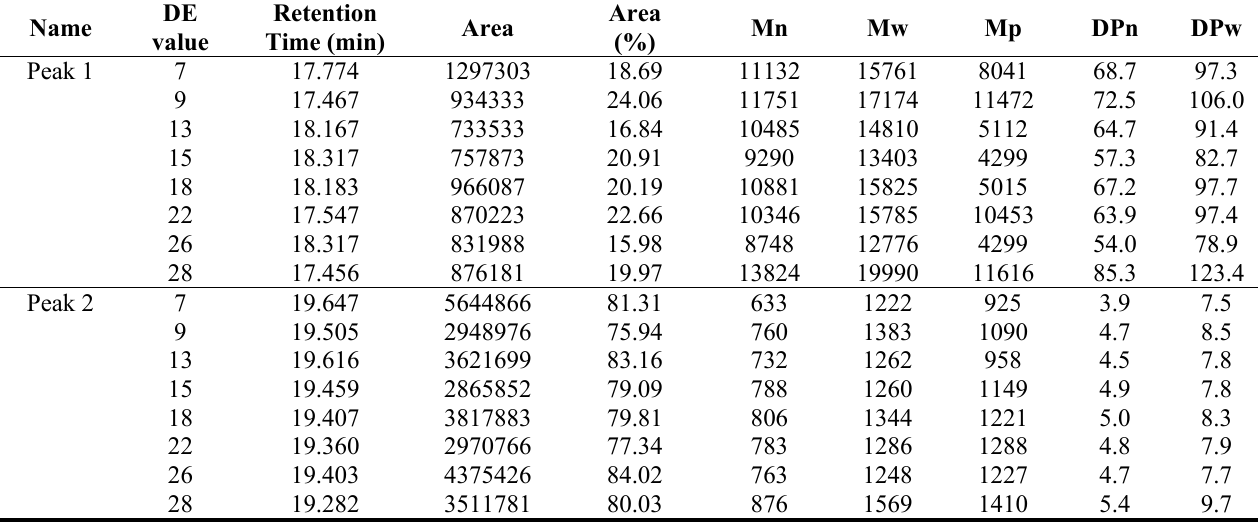
Table 1. Molecular weight of dextrins with different DE